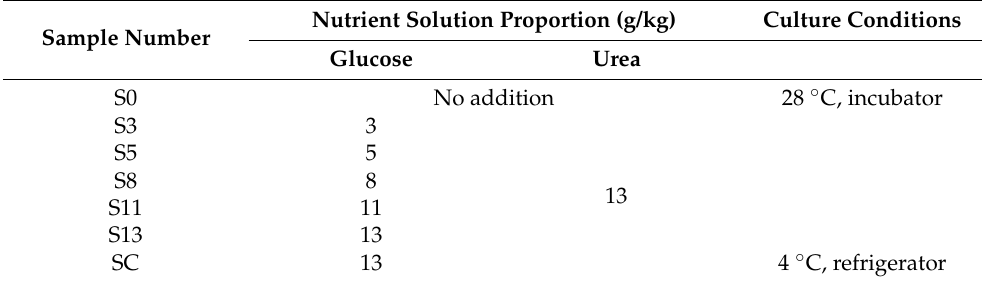
Table 2. Experimental conditions of soil